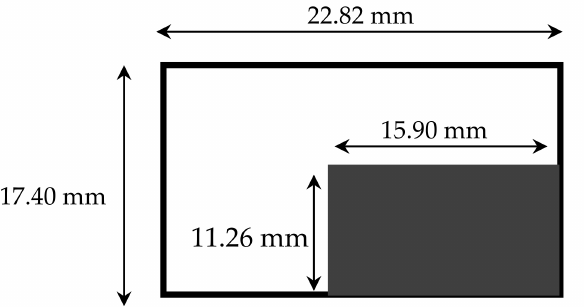
Figure 9. Antenna size comparison at 4 GHz: the light-colored rectangle represents the ordinary microstrip patch; the dark-colored rectangle represents the microstrip patch antenna with the thin